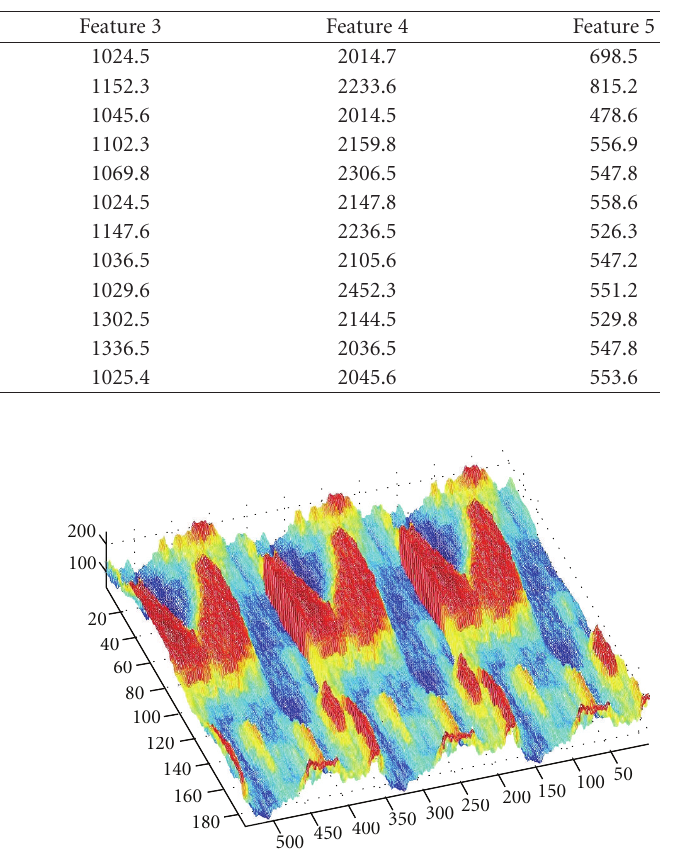
Figure 13: The constructed turbulence kinetic energy distribution surface of trigonometry Bernstein-Bezier in high-pressure reversing